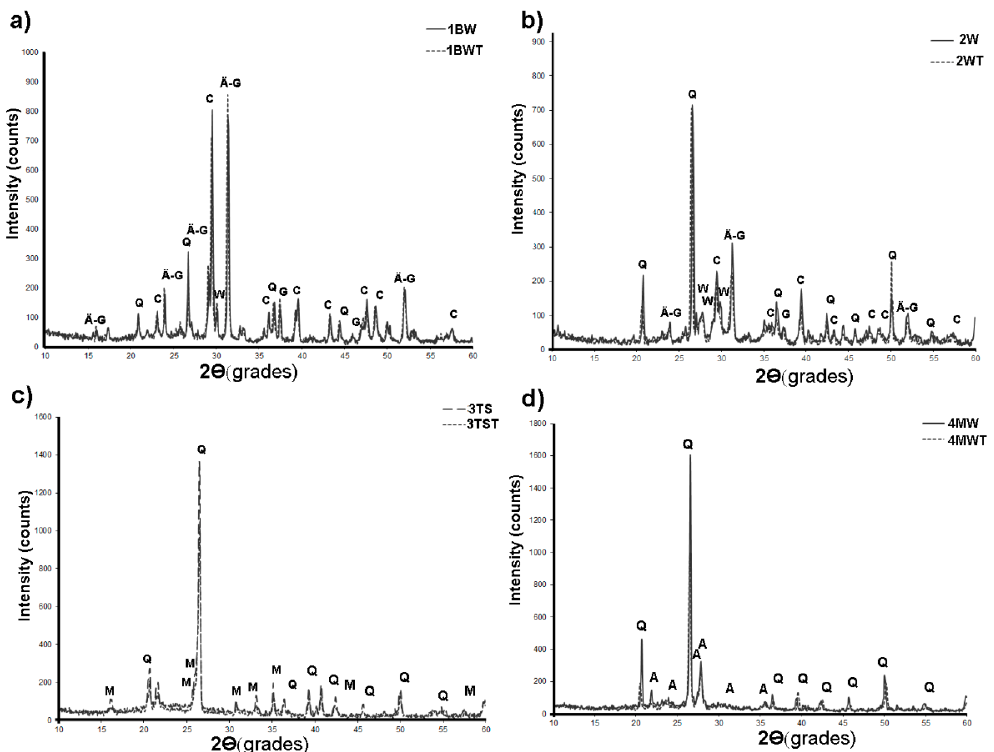
Figure 9. X-ray diffraction patterns of the ceramic body before and after the treatment: A—albite, C—calcite, G—gehlenite, Q—quartz, M—mullite, W—wollastonite and Ä—äkermanite. Diffractogram of ceramic body of the tile: ( a ) 1BW (before—1BW and after—1BWT); ( b ) 2W (before—2W and after—2WT); ( c ) 3TS (before—3TS and after—3TST); and ( d ) 4MW (before—4MW and after—4MWT).